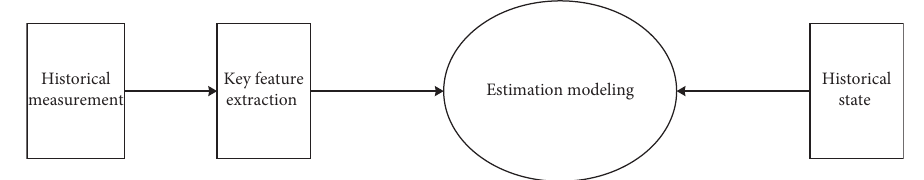
Figure 1: Modeling estimation driven by